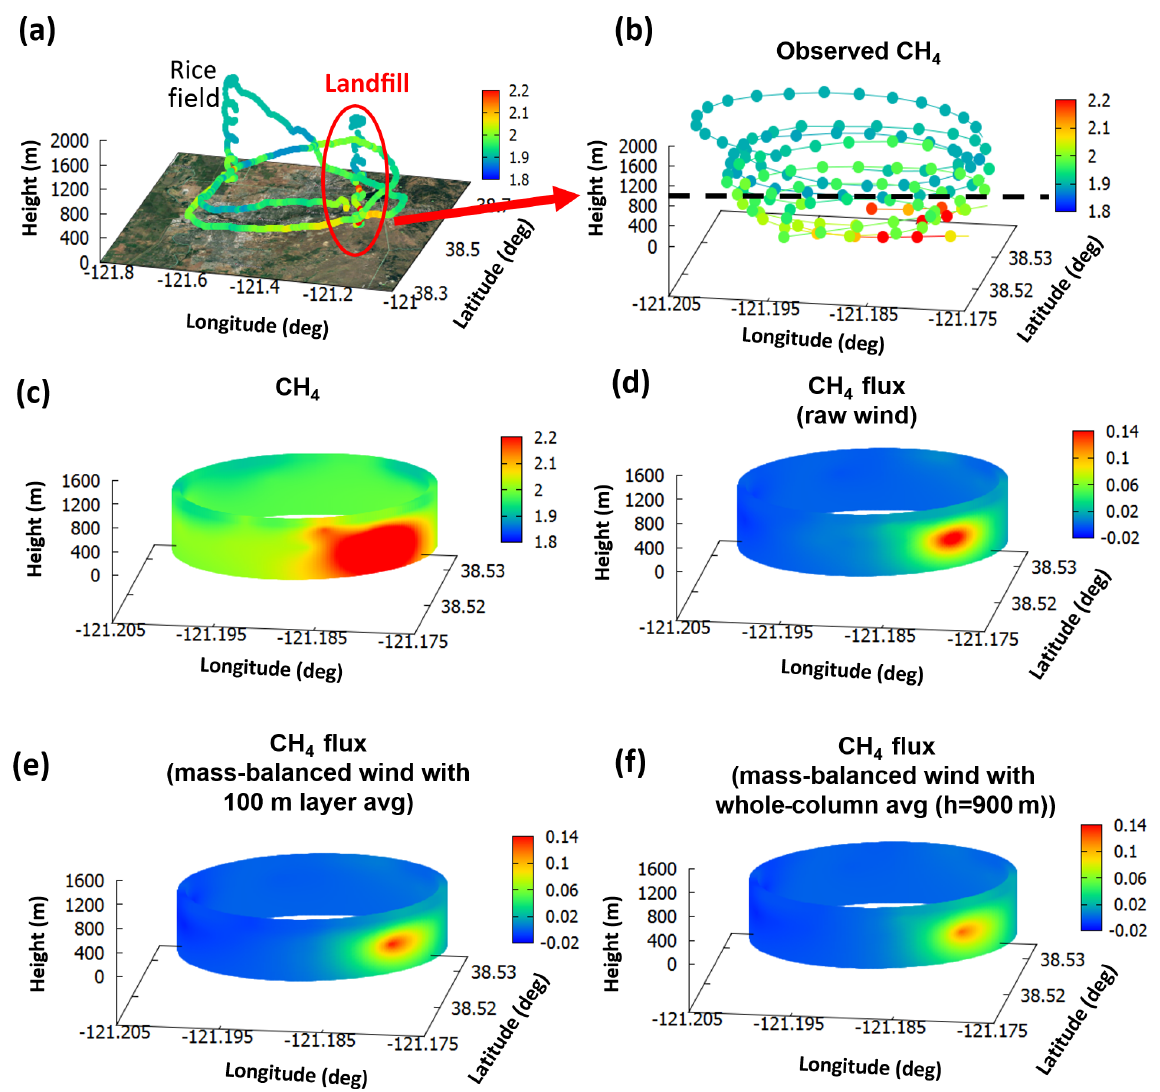
Figure 7. (a) The map of AJAX flight track with the observed CH 4 mixing ratio. (b) The observed CH 4 mixing ratio, (c) kriged CH 4 mixing ratio, (d) CH 4 flux using raw wind, (e) CH 4 flux using the mass-balanced wind with 100m vertically averaged wind, and (f) CH 4 flux using mass-balanced wind (averaged through the entire PBLH) over the landfill location on 29 July 2015. The fluxes are computed based on Eq. (2). The background value was chosen as the minimum value at each vertical layer. The approximate diameter of the cylinder is 3km, and the color scale is capped at 2.2ppmv in panels (a) – (c) . The black dashed line represents the top of the PBLH for this flight. Panels (c) – (f) are only shown below the